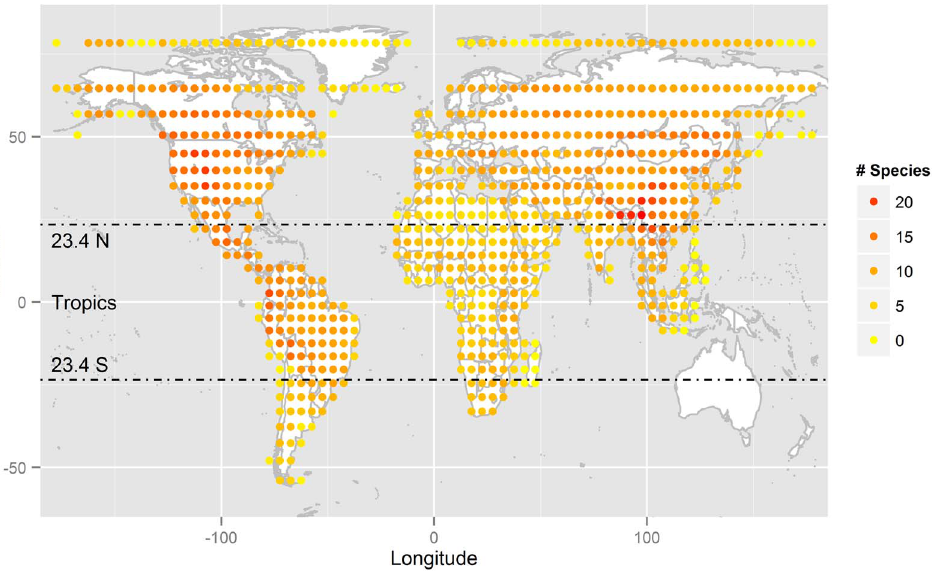
Figure 2. Caniformia species richness distribution in a Behrmann Equal Area projection of 5 6 equivalents (482 km 6 482 km) grid size, with the tropics marked.